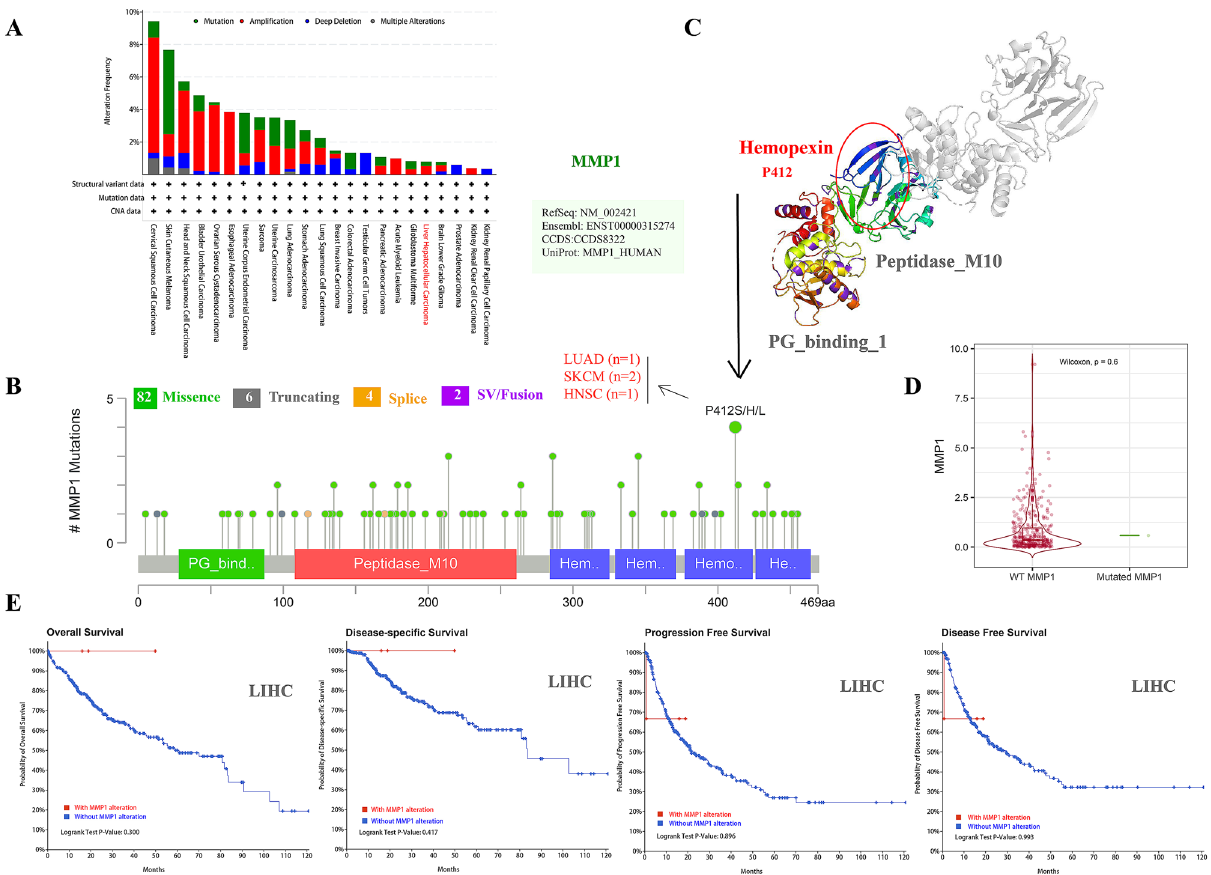
Figure 4. Genetic variation features of MMP1 in different cancers based on TCGA via cBioPortal. ( A ) The mutation frequency and mutation types in diverse cancers; ( B ) Potential sites of mutation; ( C ) mutation site with highest frequency (P412S/H/L) in the 3D version of MMP1 and related carcinomas; ( D ) Comparison of expression level between mutated and WT MMP1; (E) MMP1 alteration impact on OS, DSS, DFS, and PFS of liver hepatocellular carcinoma (LIHC) by the cBioPortal. WT, wild type; OS, overall survival; DSS, disease- specific survival; DFS, disease free survival; PFS, progression free survival; * P < 95%CI = 1.020–1.987, P = 0.038) for DSS (Table 5), so as tumor-bearing status (HR = 14.440, 95%CI = 8.484– 24.580, P < 0.001), vascular invasion (HR = 1.536, 95%CI = 1.009–2.337, P = 0.045) and MMP1 expression (HR = 1.204, 95%CI = 1.003–1.446, P = 0.047) for PFI (Table 6). According to the univariate and multivariate cox regression analysis above, MMP1 were deemed an important independent prognostic factor in addition to clinical factors. These results showed its potential to serve as a reli- able and innovative biomarker for patients with LIHC. More importantly, in order to predict the LIHC patients’ prognosis, we constructed a nomogram incorporating MMP1 and multiple clinicopathological characteristics based on the above analysis. As shown in Fig. 7B, we could calculate the score for each variable and combined them to predict the prognosis of patients with LIHC (C-Index = 0.680, 95%CI = 0.647–0.713). As a supplement, we employed time-dependent ROC curves to assess the accuracy of MMP1 for predicting OS, DSS and PFI in LIHC patients. The AUC values for OS (2-year: 0.642, 3-year: 0.664, 4-year: 0.658), DSS (2-year: 0.677, 3-year: 0.706, 4-year: 0.684) and PFI (2-year: 0.645, 3-year: 0.647, 4-year: 0.673) (Fig. 7C). DCA (Fig. 7D) was performed to determine the clinical utility of the nomogram (C-Index = 0.614, 95%CI = 0.577–0.650). Nomogram calibration curves (Fig. 7E) showed a good predictive accuracy of the model. Validation of clinical dataset in HCC patients. Tumor/normal samples and clinicopathological data of 108 patients diagnosed with HCC and treated with surgical resection were retrieved and analyzed. MMP1 expression was higher in tumor tissues at translation level (Fig. 8A). Consistent with the result of WB, higher expression of MMP1 in tumor than normal tissues ( P < 0.001) were corroborated by qPCR (Fig. 8B). The 108 cases were divided into two groups according to MMP1 expression level: low (0–50%) and high (50–100%) expression groups. The patients’ background and baseline characteristics are summarized in Table 7. Unlike the baseline of TCGA-LIHC, there were significant differences between the groups with respect to patho- logic stage ( P = 0.019), AFP ( P = 0.020), albumin ( P = 0.026) and Child–Pugh grade ( P = 0.002) in clinical HCC cohort. Consistent with the above results, the Kaplan–Meier survival curves confirmed that the low-expression